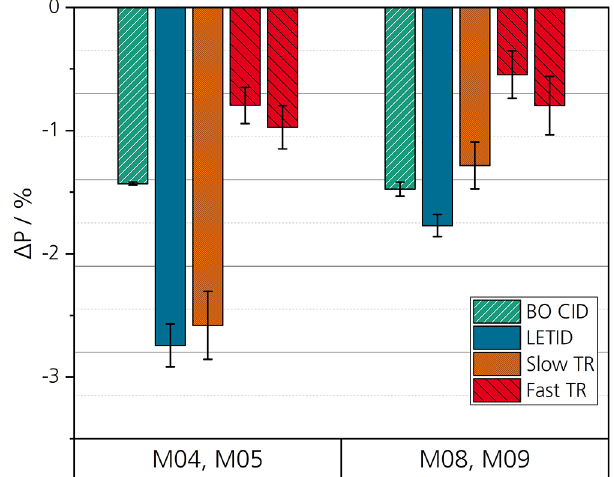
Fig. 13. Relative changes of P MPP at STC of four PV modules, which were LETID tested at 75 ° C, I SC − I MPP (M04, M05) and at 75 ° C, 2 × ( I SC (cid:3) I MPP ) (M08, M09), respectively, after BO CID, LETID and temporary recovery. Error bars: min/max values of two modules.